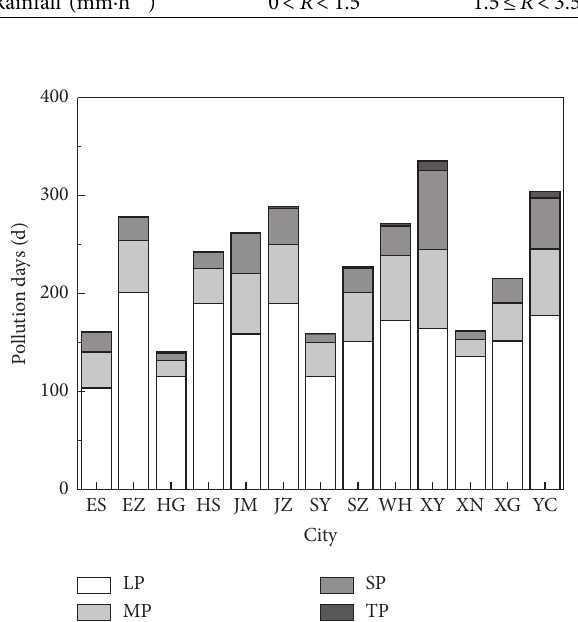
Figure 2: Distribution of different-level pollution days in 13 re- gions of Hubei Province during